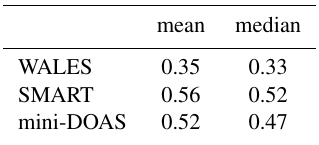
Table 4. Mean and median of the PDFs of cirrus optical thickness τ derived from WALES, SMART and